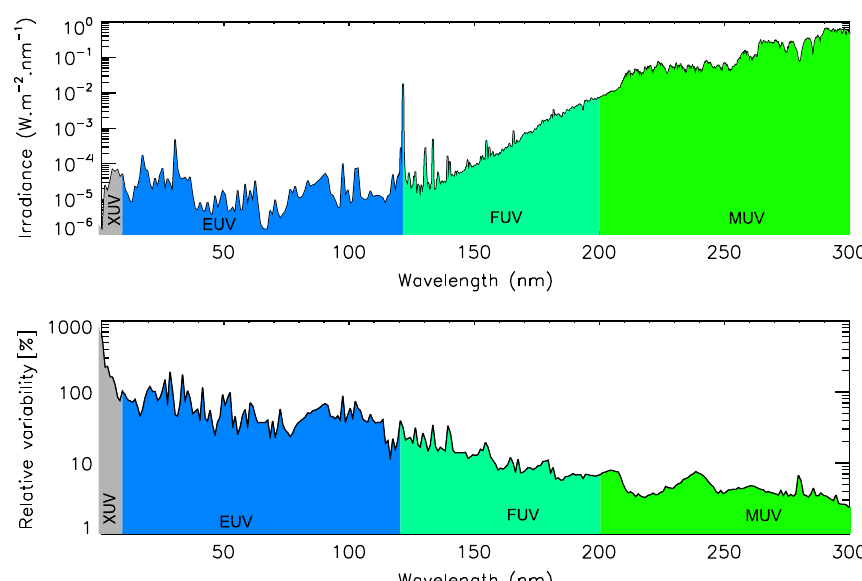
Fig. 1. Upper Panel: the solar spectrum as observed. Lower Panel: relative variability of the solar spectrum for the UV spectral range over the 11-year magnetic cycle. Adapted from Cessateur